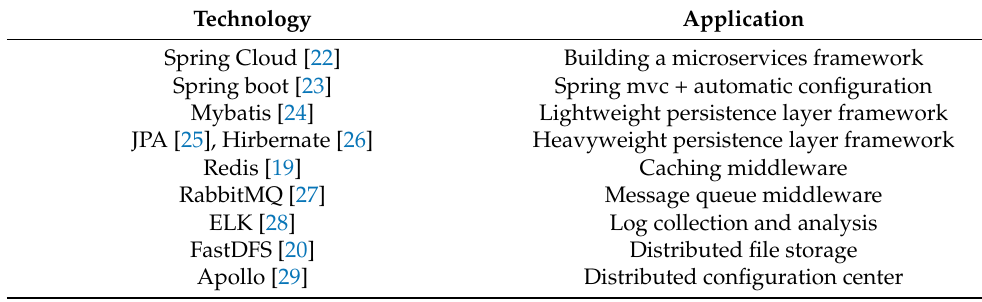
Table A1. Key technology selection.